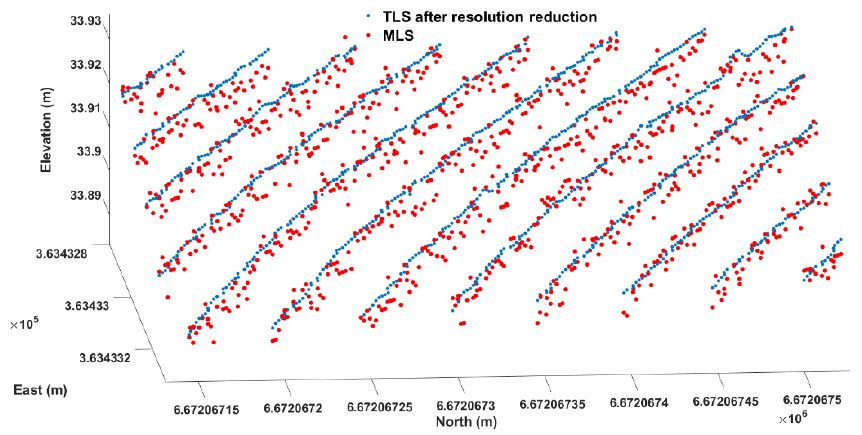
Figure 9. A piece of road surface from MLS (red dots) and down sampled TLS (blue dots) data.